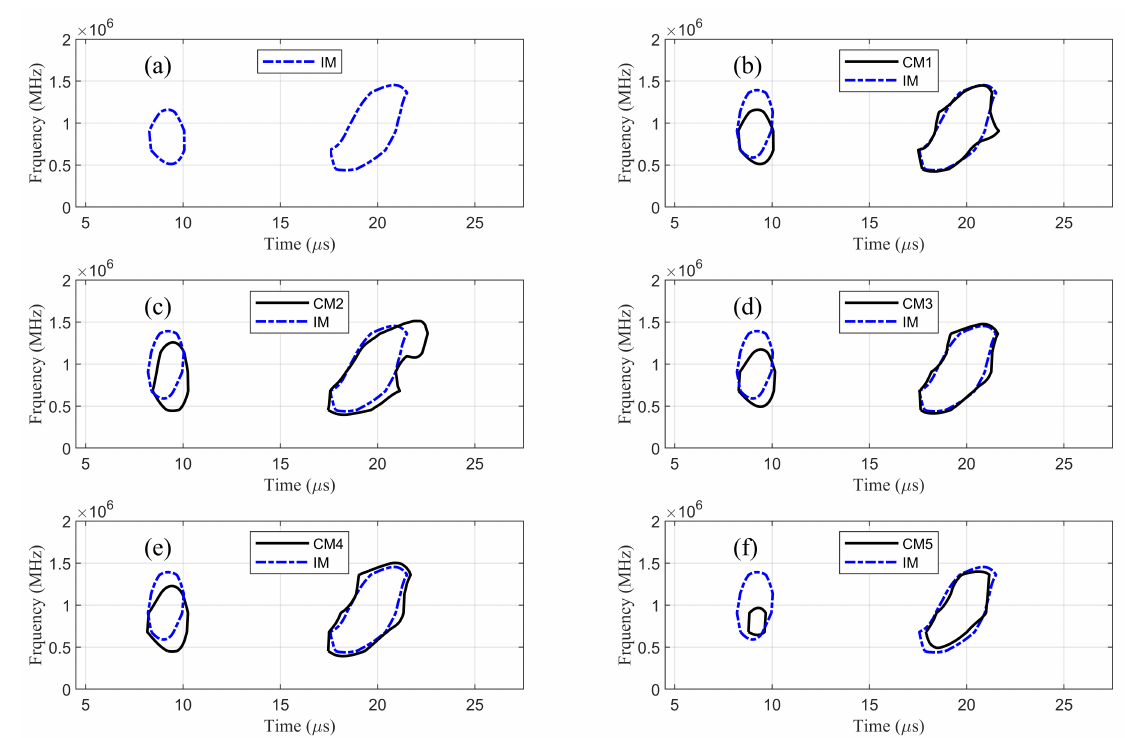
Figure 8. Half-power contours in STFT spectrograms for the six models at receiver R .